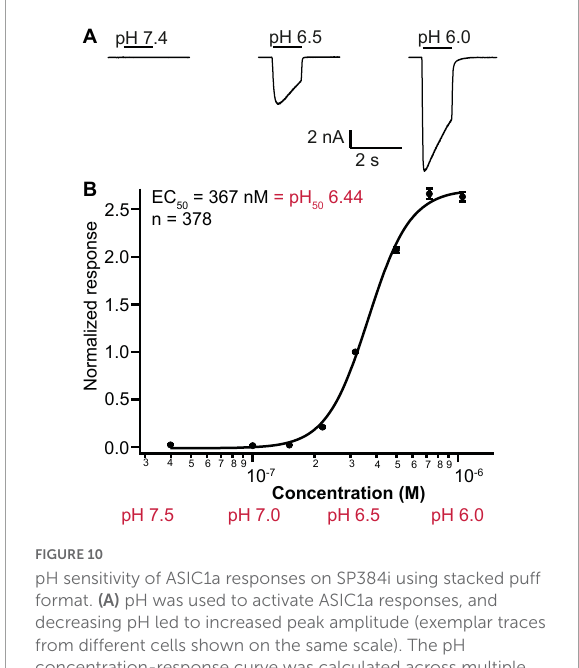
FIGURE10 pH sensitivity of ASIC1a responses on SP384i using stacked puff format. (A) pH was used to activate ASIC1a responses, and decreasing pH led to increased peak amplitude (exemplar traces from different cells shown on the same scale). The pH concentration-response curve was calculated across multiple wells (each well received 1 × pH 6.5 followed by the test pH so the data was normalized to the pH 6.5 response in each well). (B) The pH 50 was calculated to be 6.44. Mean ± S.E.M for each pH is shown by symbols from a maximum of 48 wells per pH concentration. 4X chips were